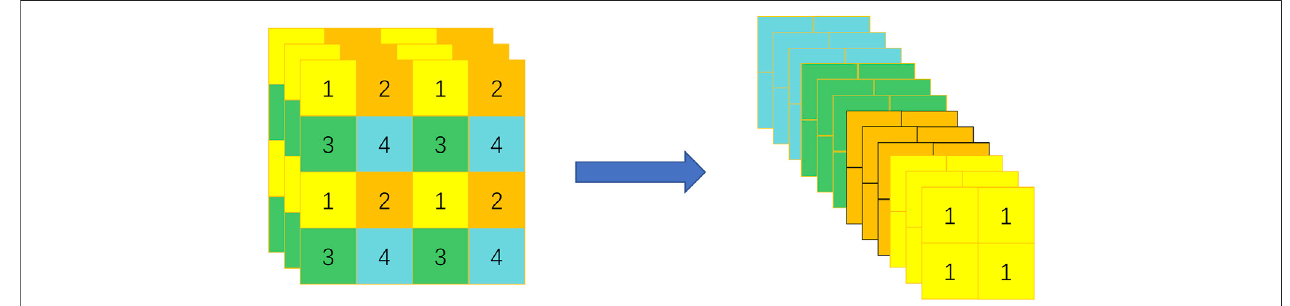
FIGURE 3 | Operation of slicing: An image is divided into four regions for slice reconstruction, with the 4 × 4 × 3 image sliced into a 2 × 2 × 12 feature map.